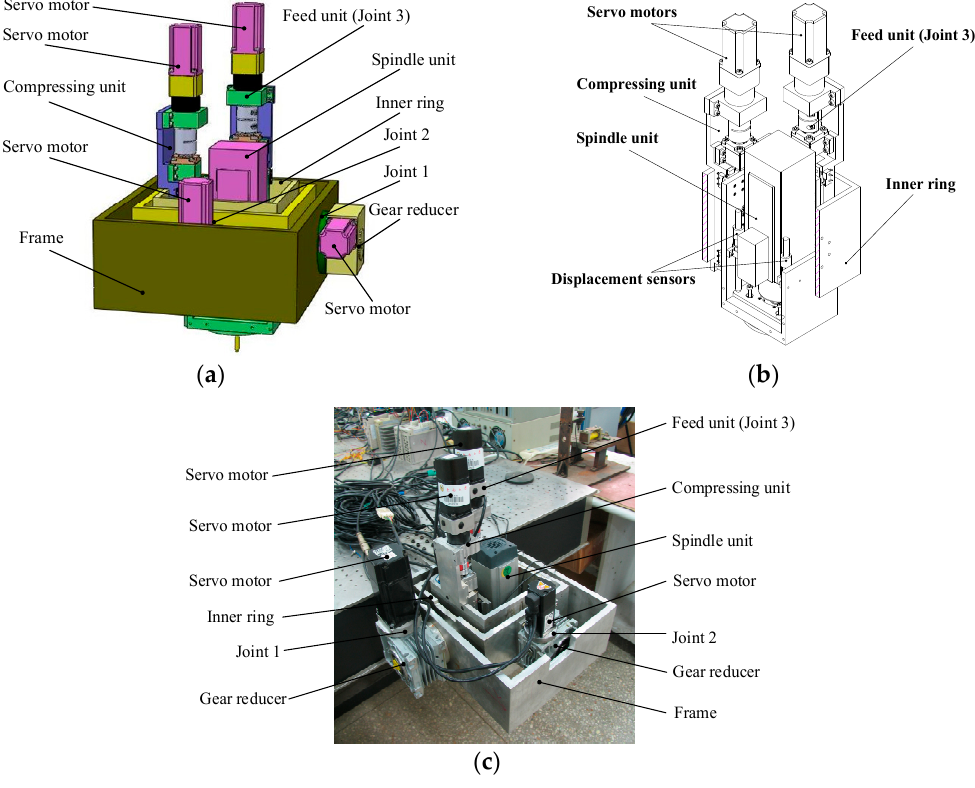
Figure 1. Structure and prototype of the designed end-effector: ( a ) the diagram of the end-effector structure; ( b ) the specific of the internal structure of the end-effector; and ( c ) the prototype of the end-effector.